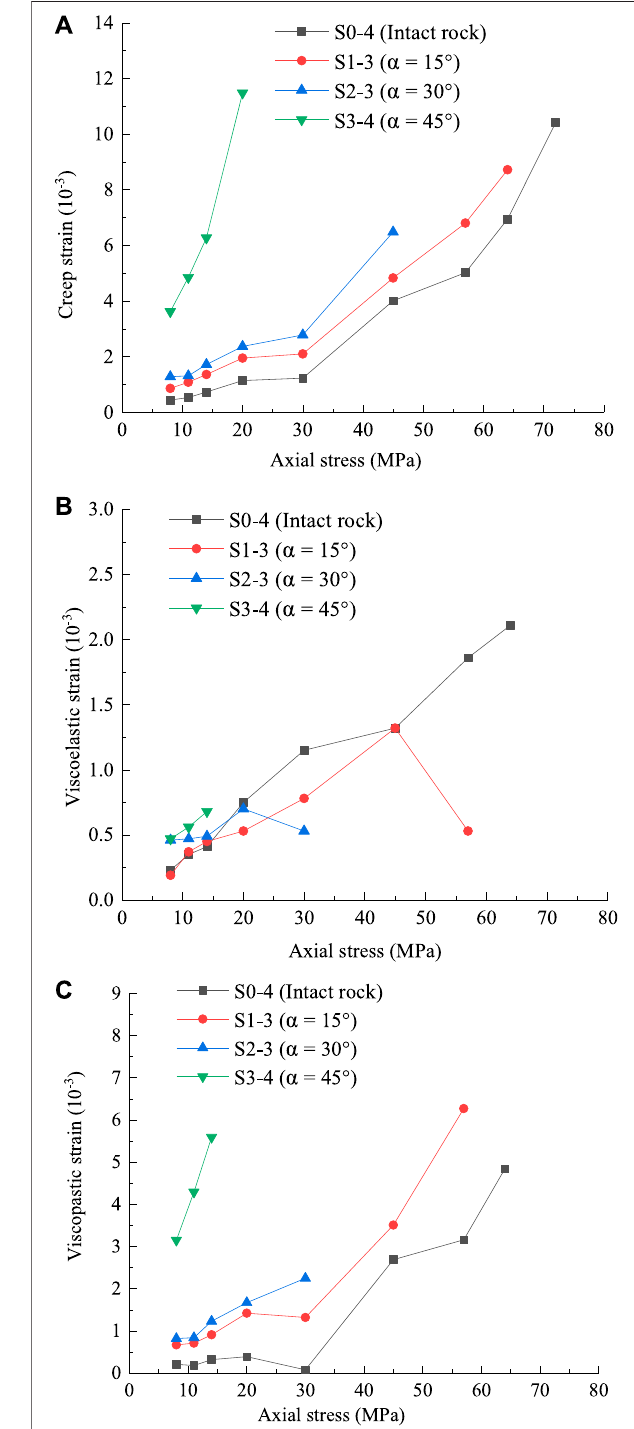
FIGURE12|(A) Creepstrain, (B) viscoelasticstrain,and (C) viscoplastic strain curves of specimens from the fi rst to the last stress levels.